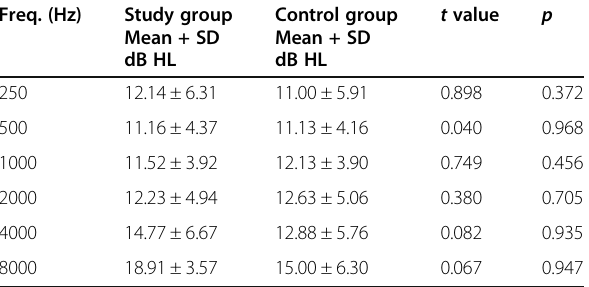
Table 2 Mean pure tone thresholds (dB HL) for both study and control groups Freq. (Hz)